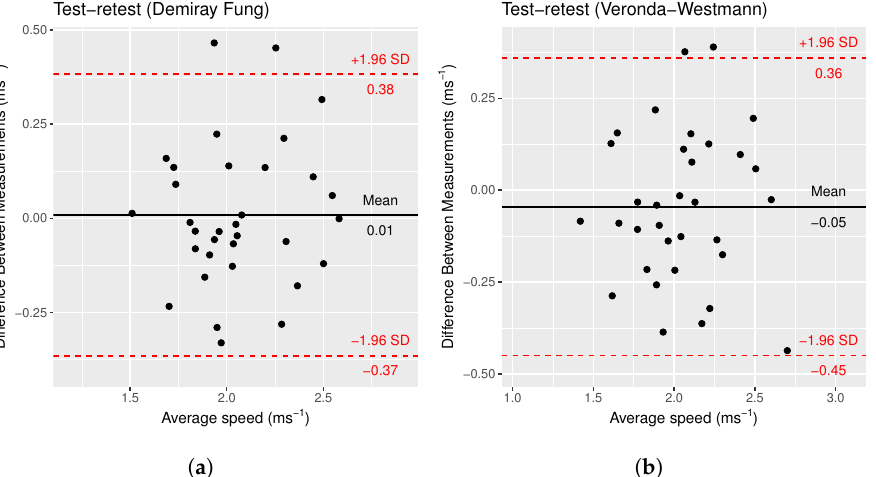
Figure 15. Bland–Altman plot of mean speed in the image for test–retest mean measured speed ( a ) DF and ( b ) VW material models. The 95% confidence intervals are marked in red. The simulated and measured elastograms were compared by measuring the RMSD difference between the images. The average RMSD of the images DF and VW was 0.41 ms − 1 (95% CI: 0.38, 0.45) and 0.47 ms − 1 (95% CI: 0.43, 0.52), respectively. Figure 16 shows the distribution of the RMSD of the images, which shows DF performed slightly better